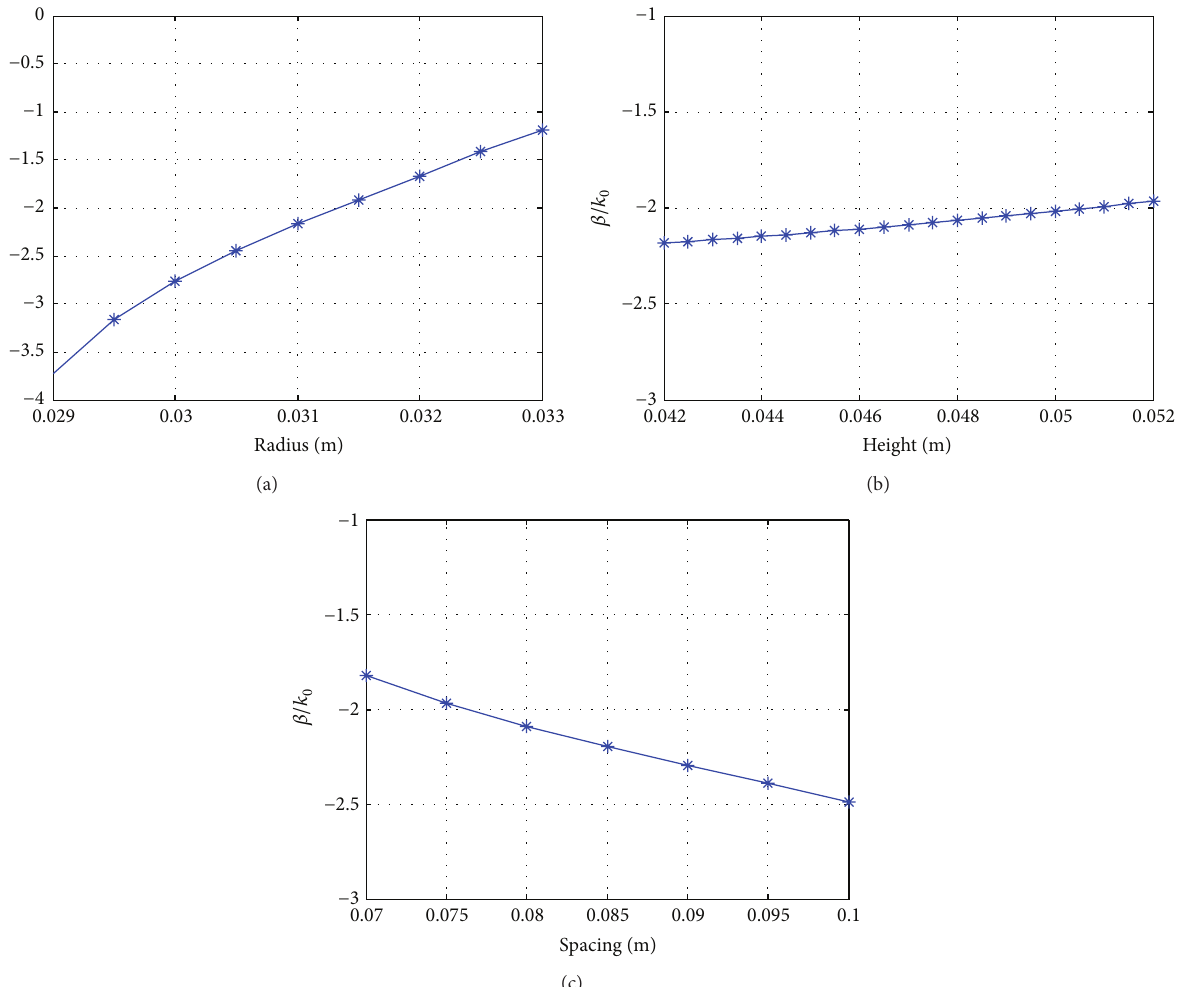
Figure 8: Parametric study on array geometry parameters: (a) radius; (b) height; (c) spacing.